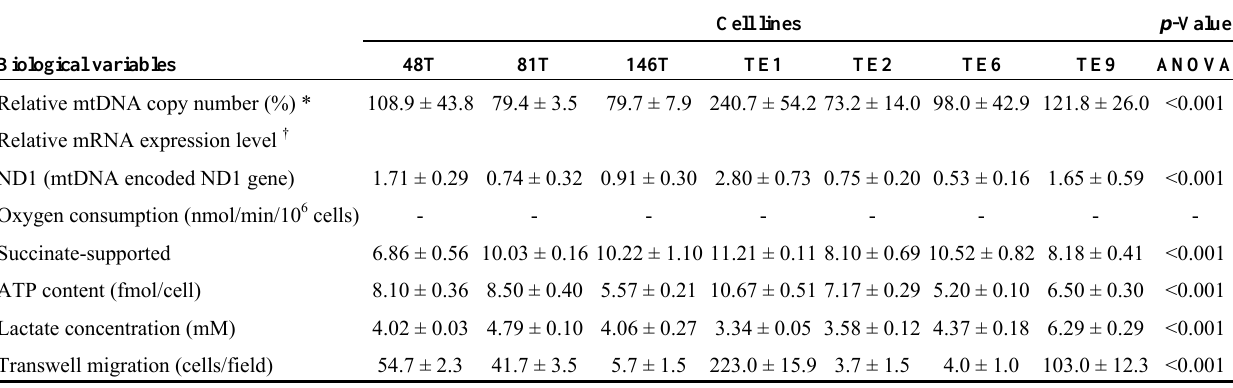
Table 1. Comparison of the relative mtDNA copy number, bioenergetic function